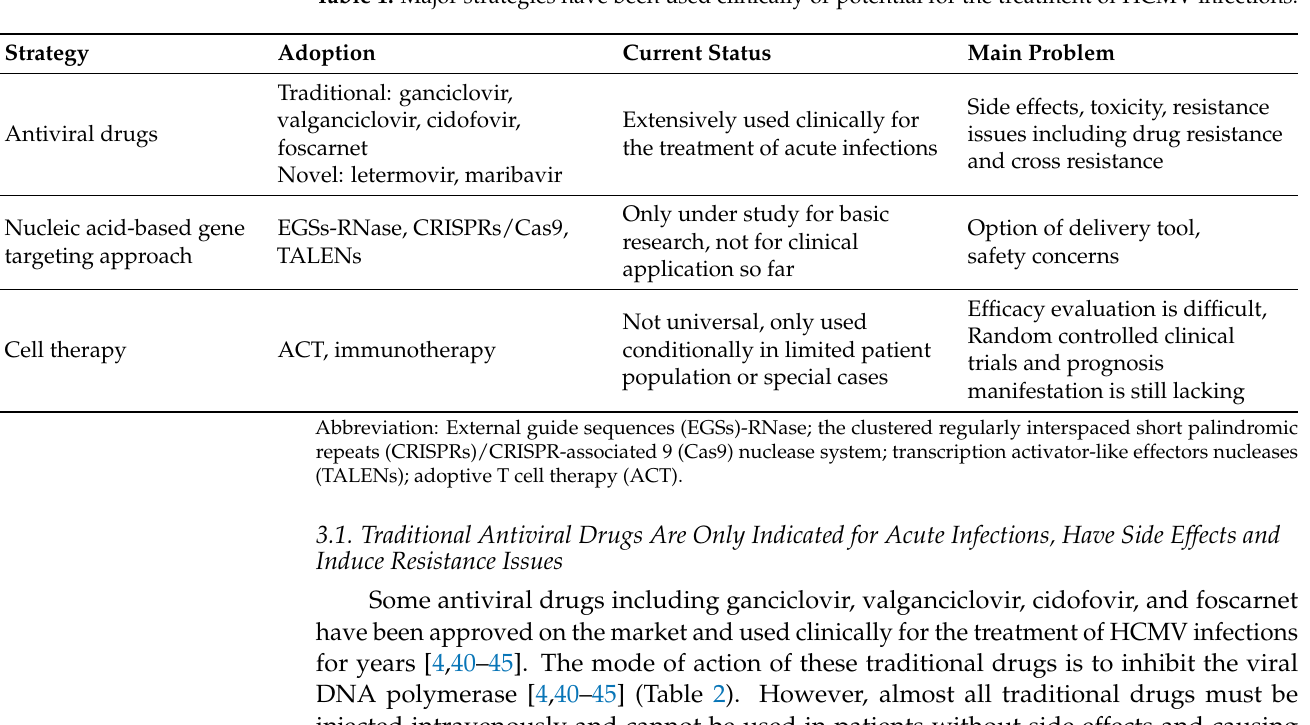
Table 1. Major strategies have been used clinically or potential for the treatment of HCMV infections.